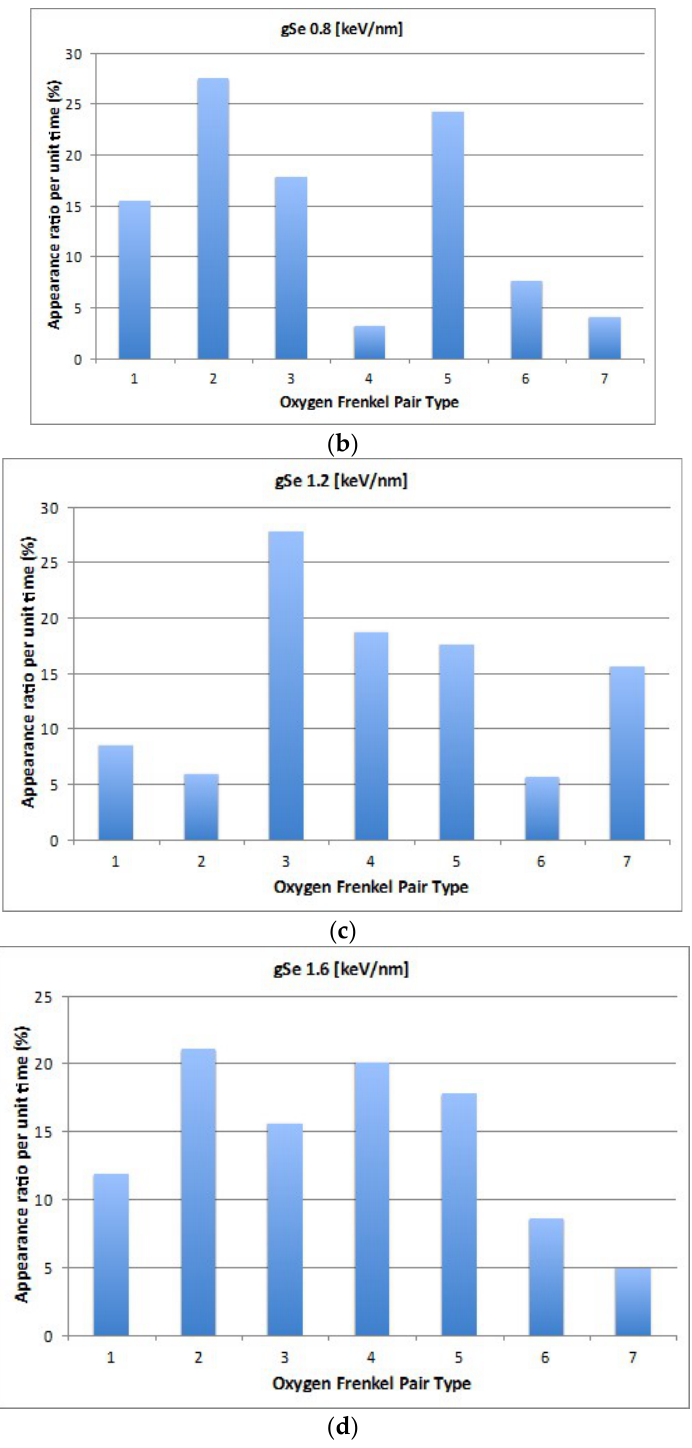
Figure 9. The time averaged distribution of i NN oxygen Frenkel pair, where i = 1, 2, …, 7, is shown for the values of gSe = 0.4, 0.8, 1.2, and1.6 keV/nm in ( a – d ), respectively.